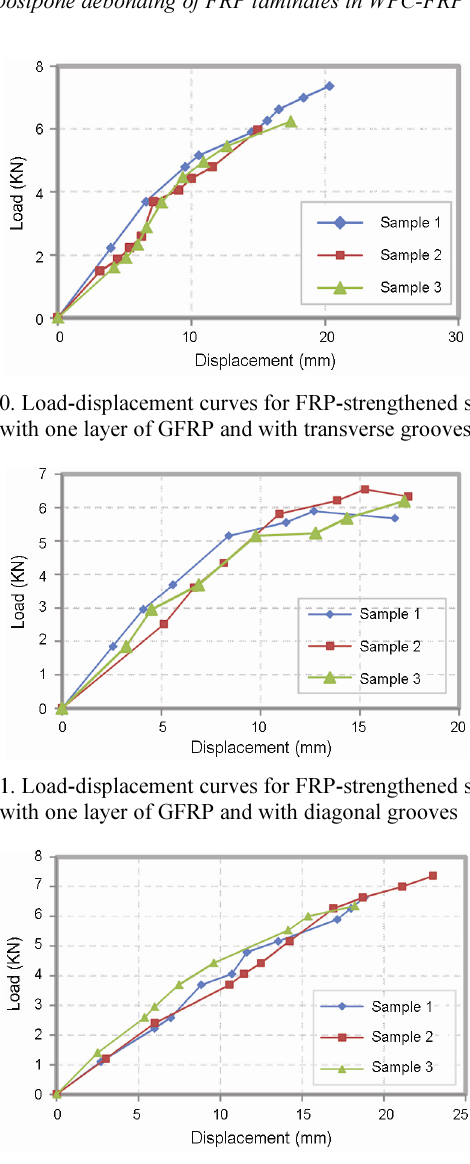
Fig. 12. Load-displacement curves for FRP-strengthened speci- mens with one layer of GFRP and with longitudinal grooves 4 mm deep